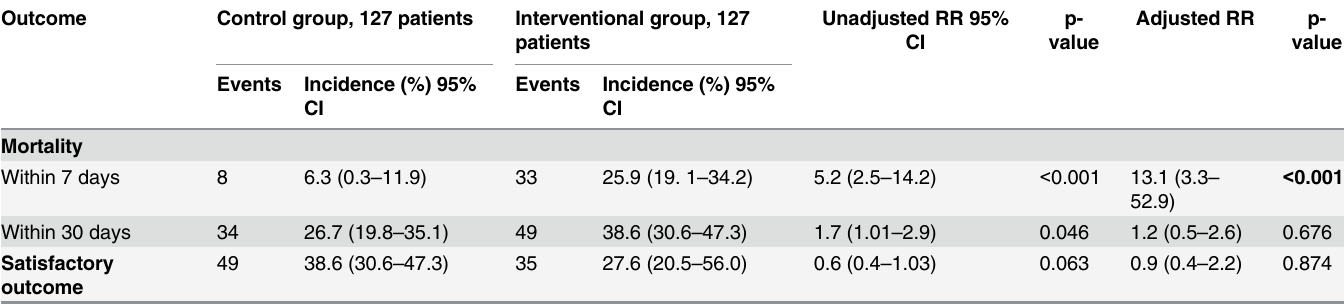
Table 4. Mortality and satisfactory outcome by treatment